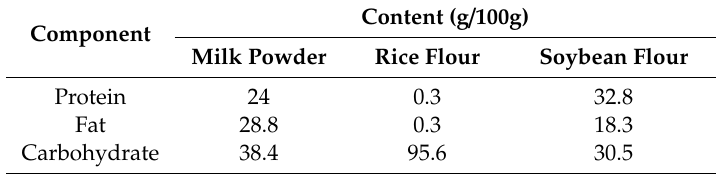
Table 1. The content of main components in milk powder, rice flour and soybean